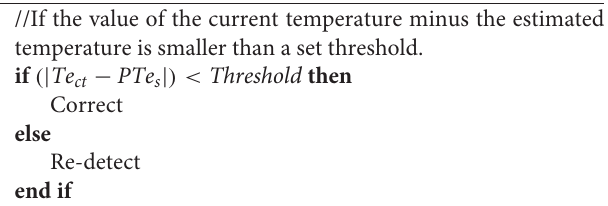
Algorithm 1: Temperature detection algorithm.